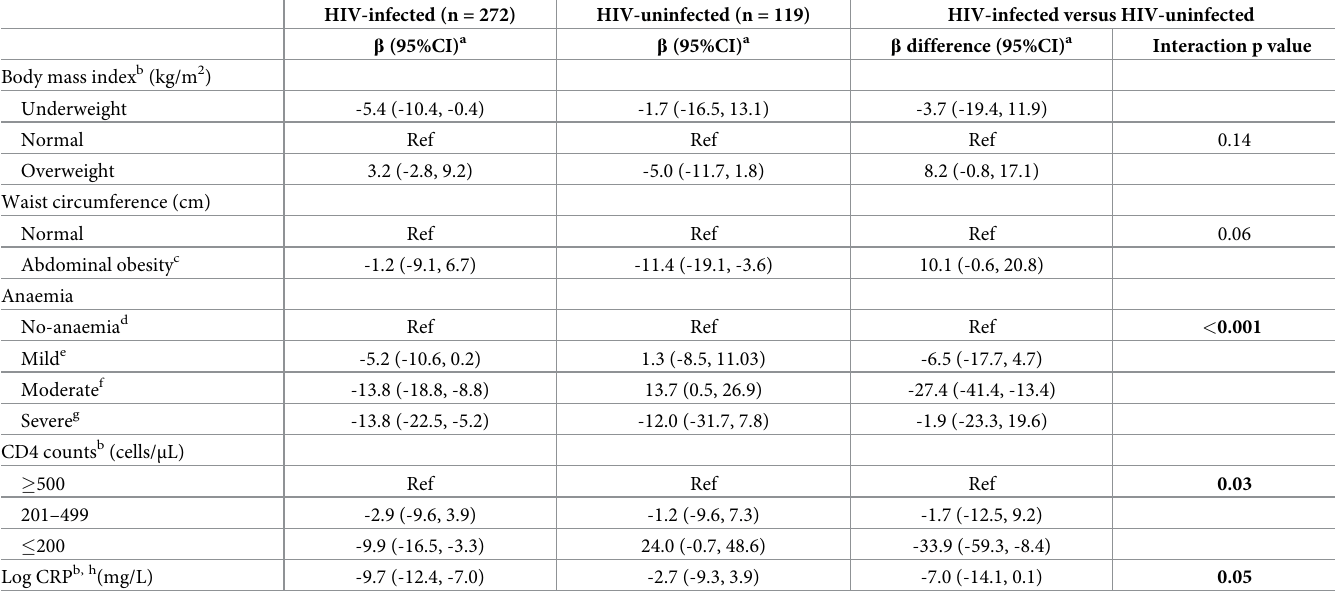
Table 2. Correlates of physical activity energy expenditure (kj/kg/day) among HIV-infected and HIV-uninfected